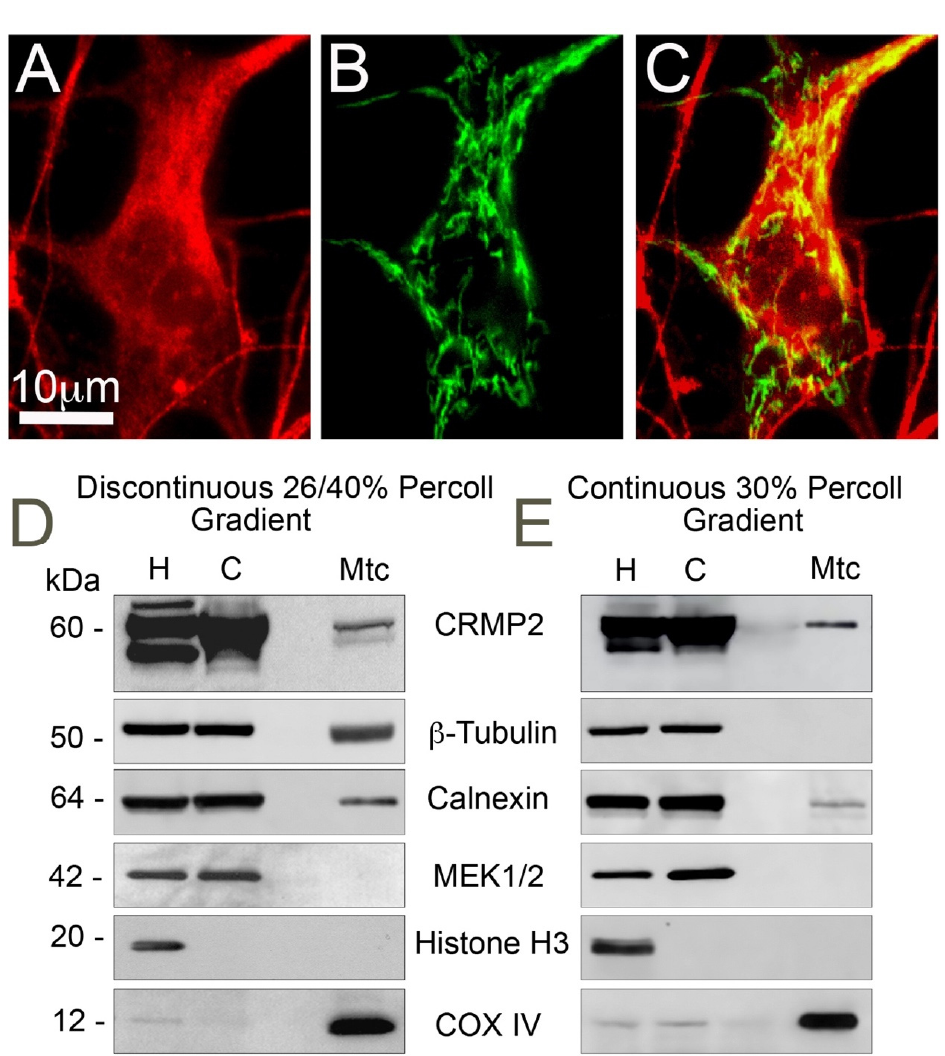
Figure 1. Interaction of CRMP2 with brain mitochondria. ( A – C ) Immunocytochemistry staining with anti-CRMP2 antibody ( A , red) and visualization of mitochondria with mitochondrially targeted enhanced yellow fluorescent protein (mito-eYFP) ( B , green) illustrates co-localization of CRMP2 and mitochondria (yellow, C ) in cultured striatal neuron from FVB/NJ mouse. ( D , E ), CRMP2 binds to synaptic brain mitochondria isolated from FVB/NJ mice. Mitochondria were purified either on discontinuous 26/40% Percoll gradient ( D ) or on continuous 30% Percoll gradient ( E ) as described in the Materials and Methods. H: homogenate; C: cytosolic fraction; Mtc: mitochondrial fraction. MEK1/2, calnexin, β -tubulin, Histone H3, and COX IV are cytosolic, ER, microtubule, nuclear, and mitochondrial markers, respectively. Representative western blots from 3 independent experiments are